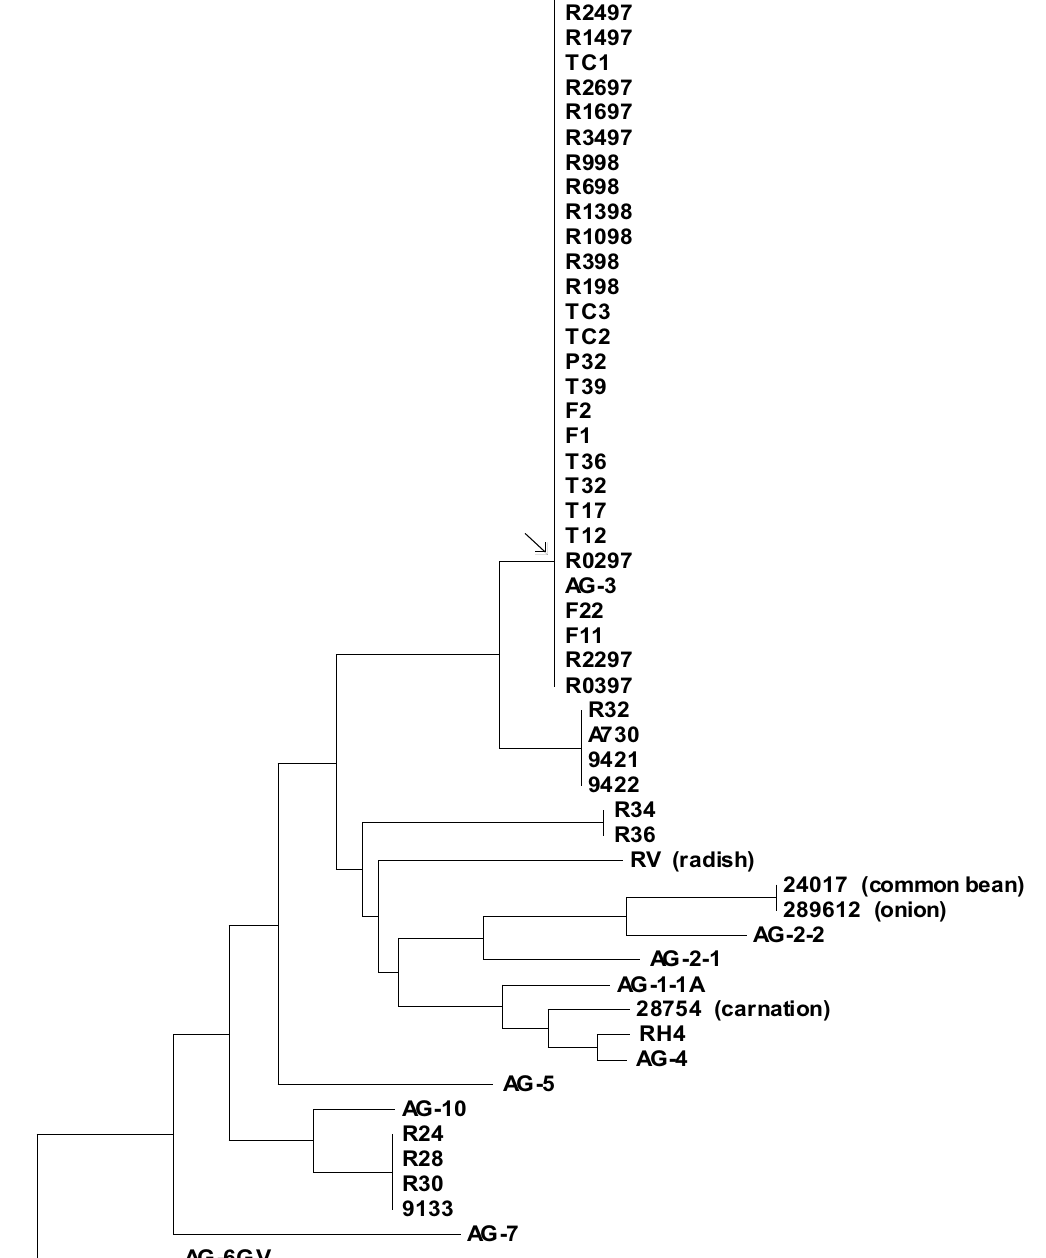
Fig. 4. Dendrogram constructed from PCR-RFLP data of ITS1–5.8S–ITS2 of Rhizoctonia solani isolates using the neighbour-joining method from the distance matrix calculated and analysed as described in the text. For isolates codes and sources see Table